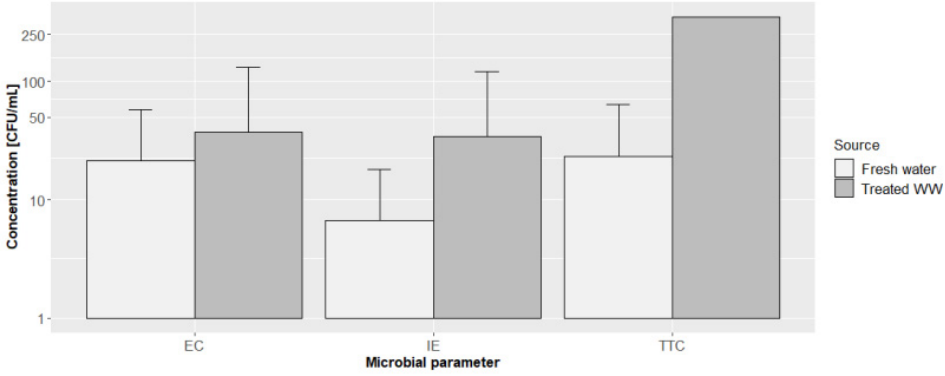
Figure 9. Quality of the two irrigation water types in terms of the content of thermotolerant coliforms (TTC), Escherichia coli (EC) and intestinal enterococci (IE). Table 8. Harvest data from the irrigation field